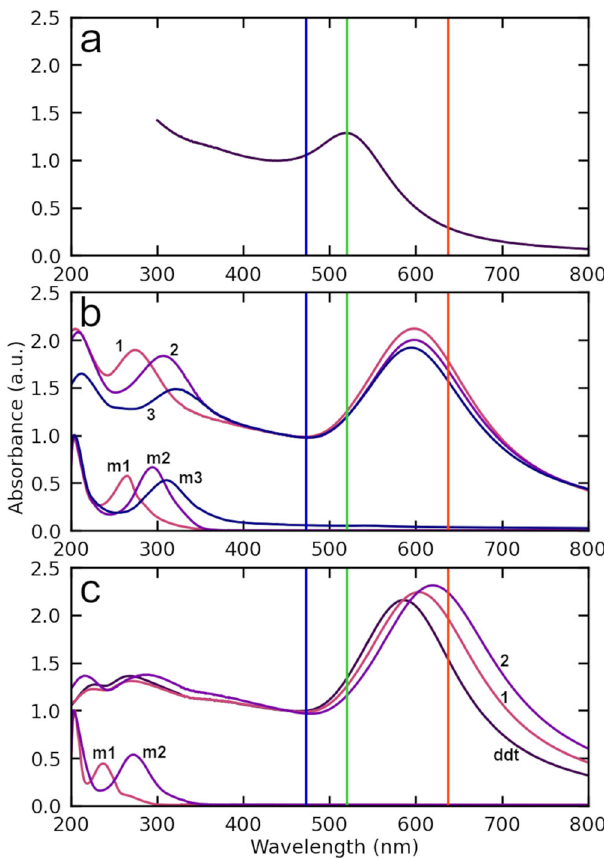
Fig. 4 Normalized UV – Vis absorbance spectra of various molecules in solution, NP fi lms and X-NS on quartz prepared using various molecules. a NPs in a hexane solution. b X-NS prepared using oligophenylenedithiols (HS-(C 6 H 4 ) n -SH with n = 1, 2, 3) and corresponding oligophenylenedithiols in solution (m1, m2, and m3, respectively). c NP fi lms prepared using dodecanethiol (ddt), phenyl- and biphenyl-thiol (H-(C 6 H 4 ) n -SH with n = 1, 2) and corresponding conjugated thiols in solution (m1 and m2, respectively). Blue, green and red lines denote 473, 520, and 638 nm excitation wavelengths, respectively, used for photoconductivity measurements discussed below. See Supplementary Information for UV – Vis spectra prior to